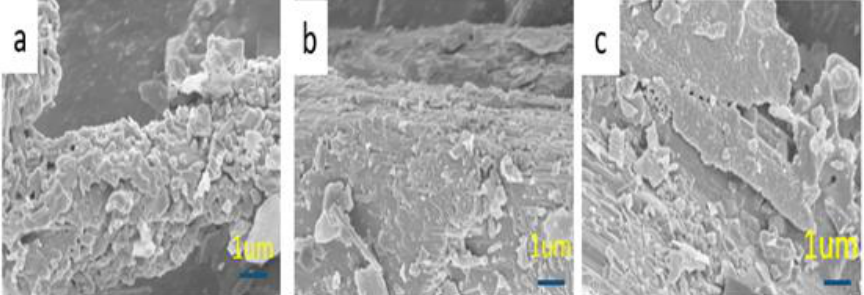
Figure 10. SEM surface images of the MKPCs with different contents of metakaolin: ( a ) 3, ( b ) 5, and ( c ) 10 wt.% after calcination at 1000 °C for an hour.